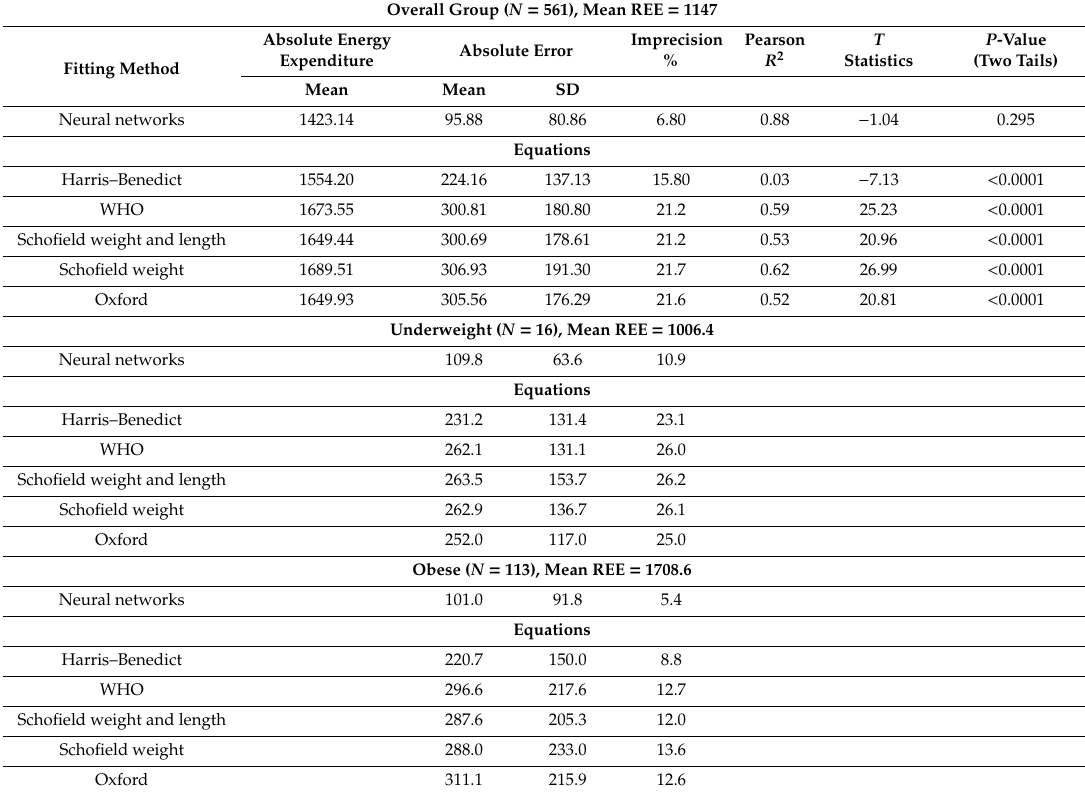
Table 2. Fitting performances of true REE by methods under study and statistical comparison of fitting methods with paired Student T test.